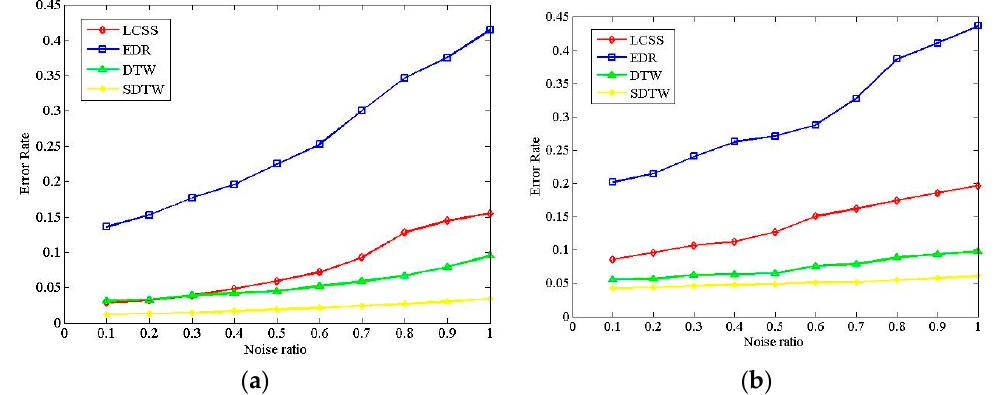
Figure 12. Comparison of noise effect on the algorithms. ( a ) Clustering error rates based on the Cross dataset; and ( b ) clustering error rates based on the Labomni dataset.